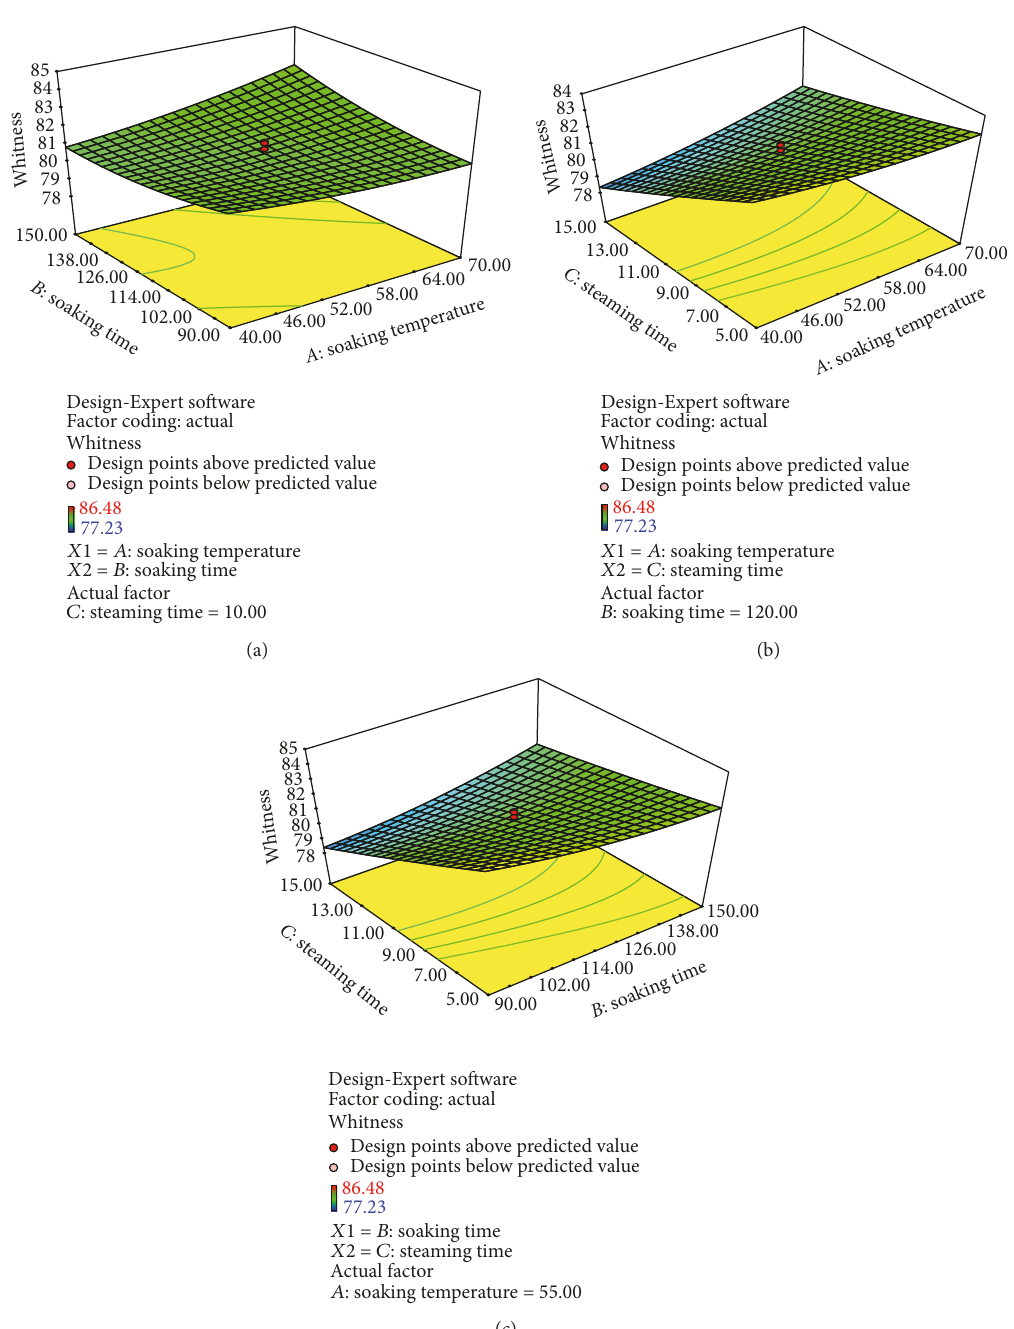
Figure 5: Effect of soaking temperature, soaking time, and steaming time on